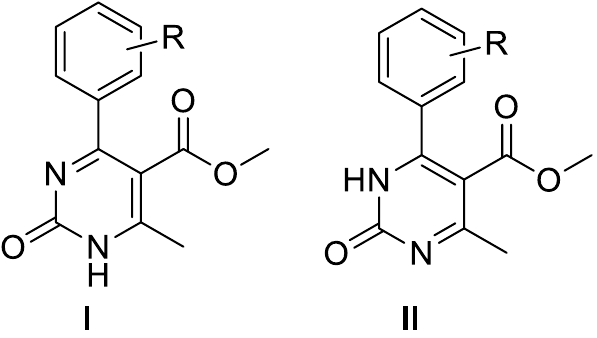
Figure 1. Tautomeric forms of oxidized dihydropyrimidines.